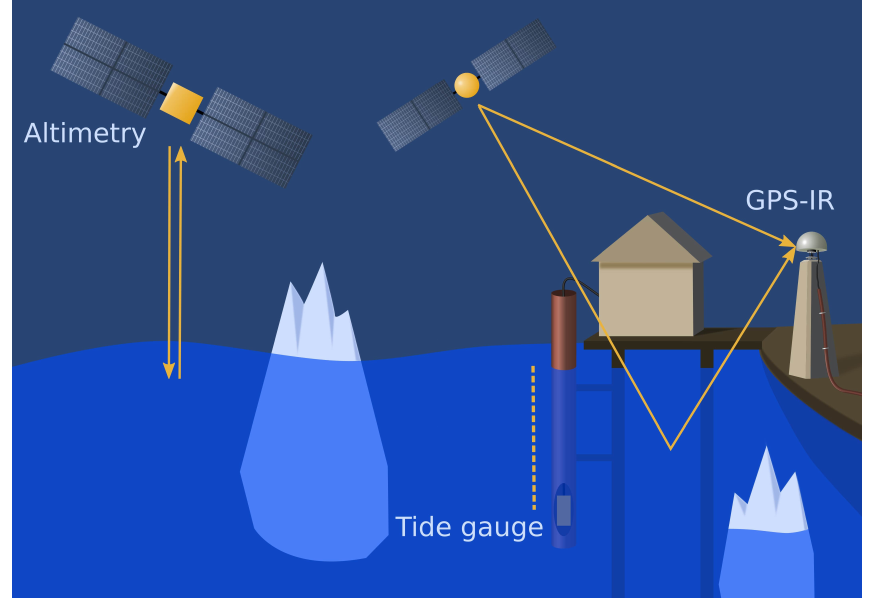
Figure 1. Illustration of the three methods used for measuring sea level in Thule in this